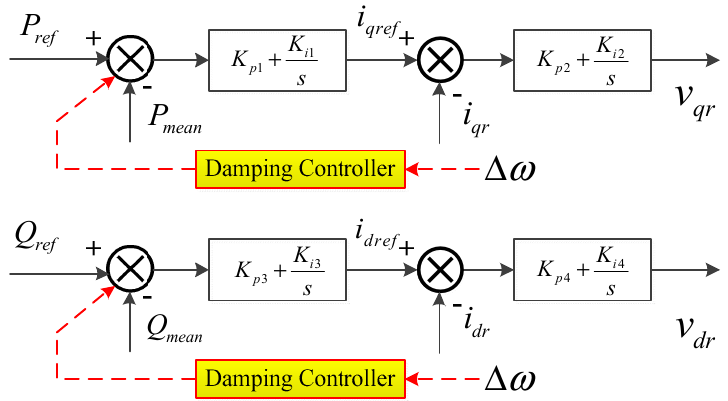
Figure 3. Control structure of the DFIG rotor-side converter.